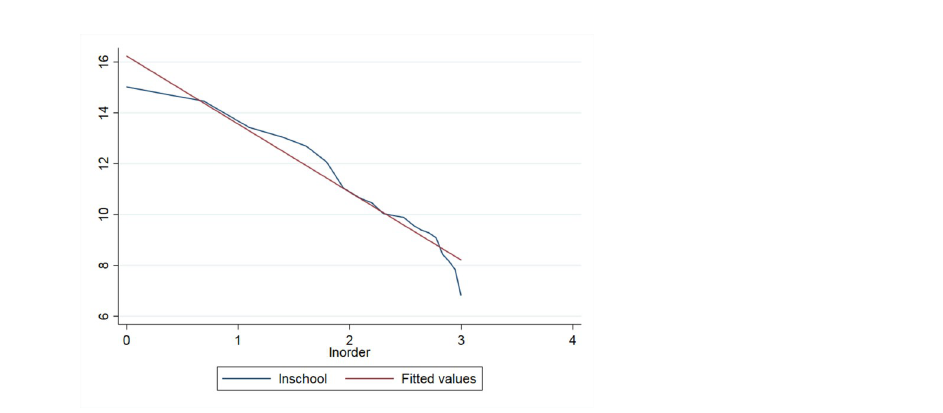
Fig 2. The double logarithmic distribution curve of school numbers for different education categories in China from 2003–2014.